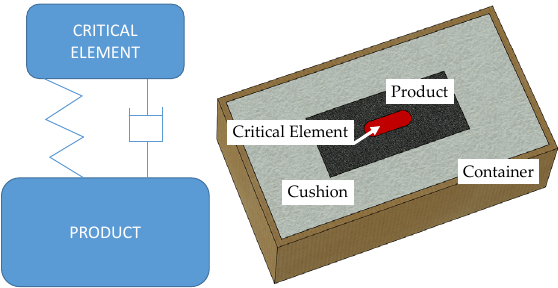
Figure 1a, b. The conceptual structure of packaging system using cushion material After the packing process, the packaged-product is usually stored for a while before it will be shipped to